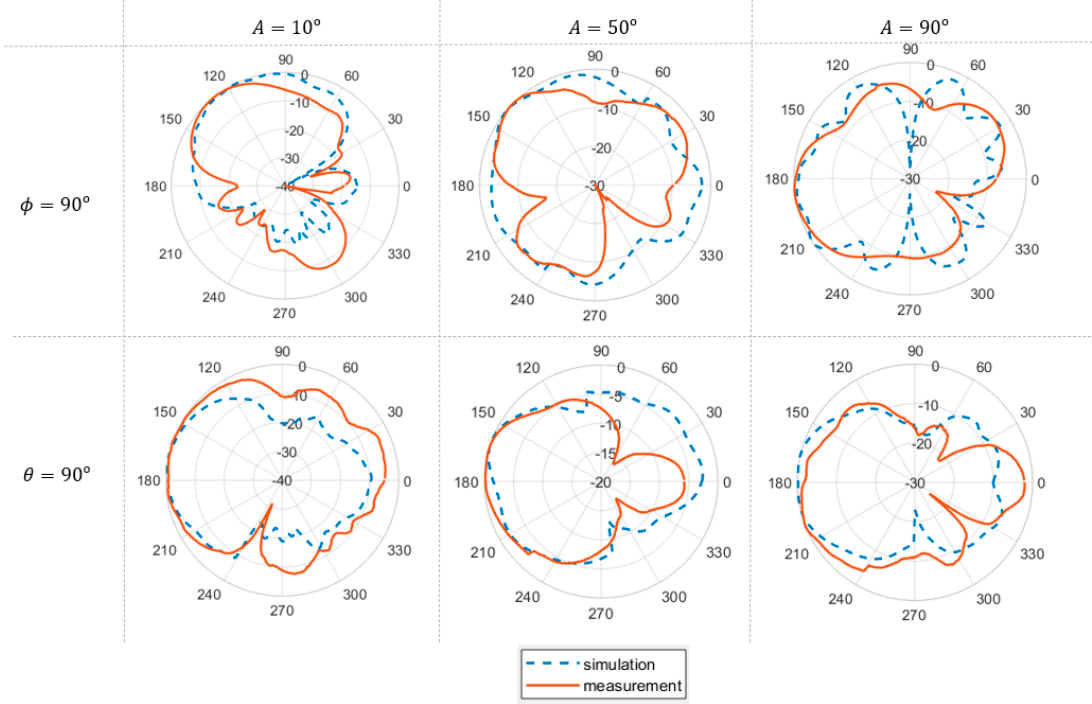
φ = 90 ◦ and θ = 90 ◦ of simulation and Figure 7. Radiation patterns for plane (cid:2038) = 90° and θ = 90° of simulation and measurement. Figure 7. Radiation patterns for plane